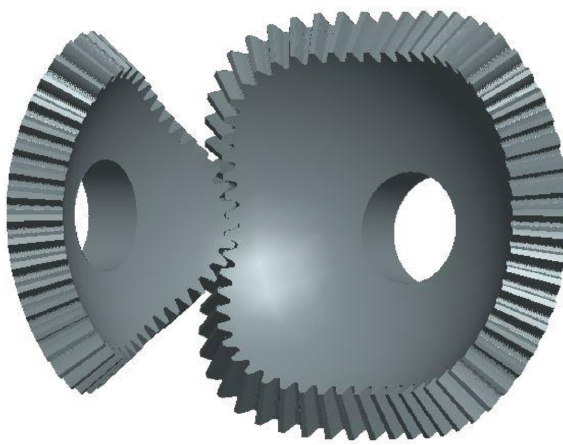
Figure 1. 3D modeling of noncircular bevel gears.